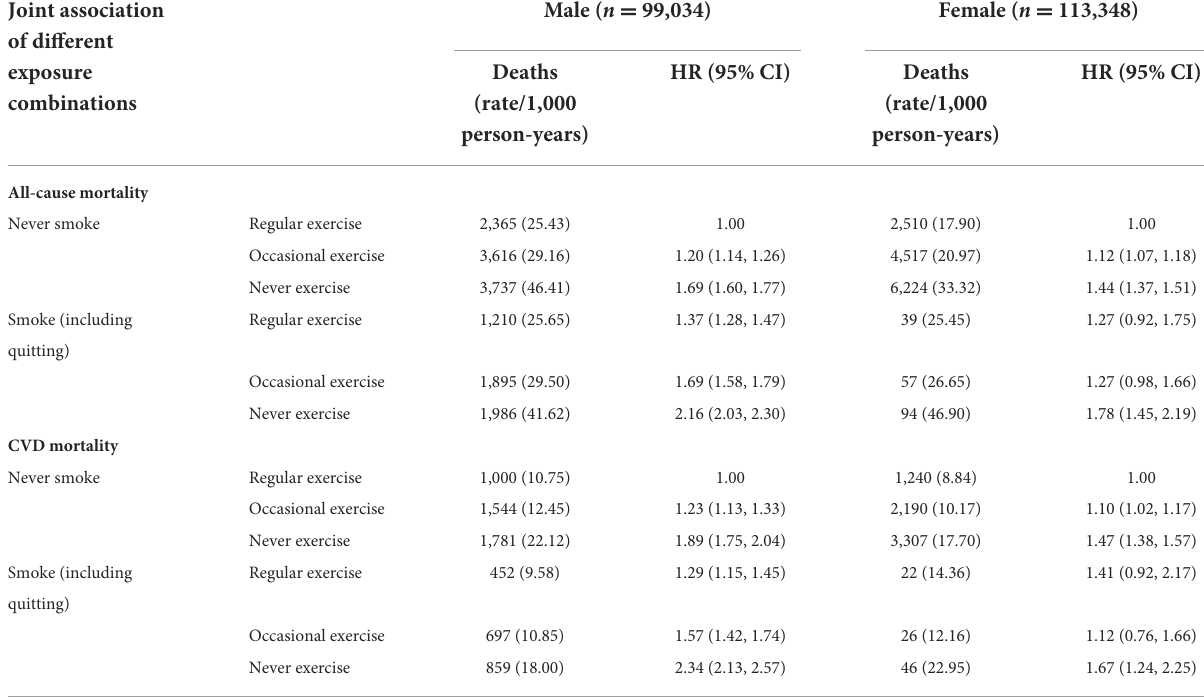
TABLE 4 The joint association of smoking and physical activity on mortality stratified by gender a